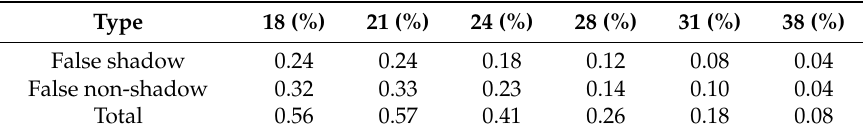
Table 8. The error generated by the height accuracy of the